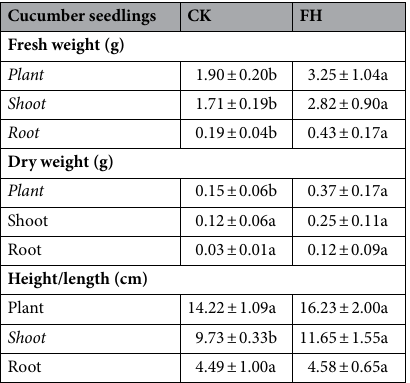
Table 1. Effects of Bacillus amyloliquefaciens FH-1 inoculation on cucumber seedlings. Values (means ± SD, n = 5) within the same row followed by different letters are significantly different at P < 0.05 according to Independent-Samples t Test. CK non-inoculated, FH inoculated with Bacillus amyloliquefaciens FH-1.